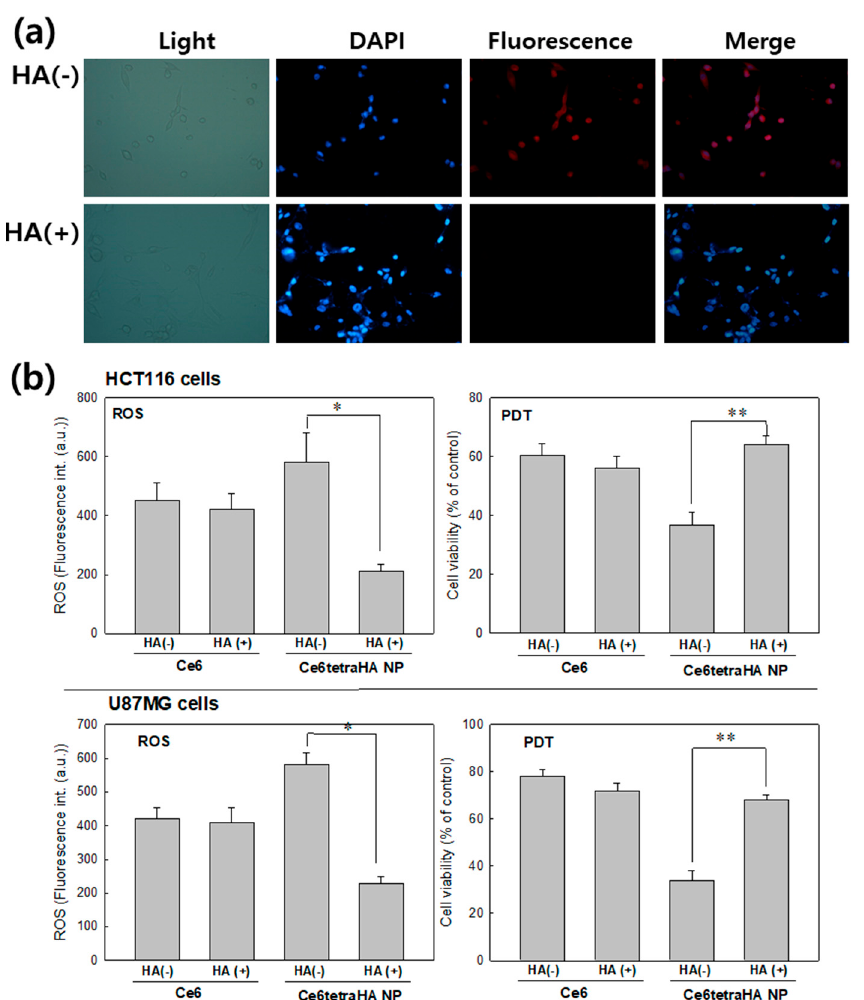
Figure 9. ( a ) The e ff ect of blocking of CD44 receptor. Fluorescence images of U87MG cells. For blocking of CD44 receptor, 10 times higher amount of free HA was pre-treated for 60 min. before treatment of Ce6 or nanophotosensitizers. ( b ) ROS generation and PDT e ff ect on the cancer cells. For fluorescence images, Ce6 concentration was adjusted to 3.35 µ M (2.0 µ g / mL) and exposed to cells for 60 min. All values are average ± S.D. from results of a single independent experiment with eight replicate. *; p < 0.001. **; p < 0.001.